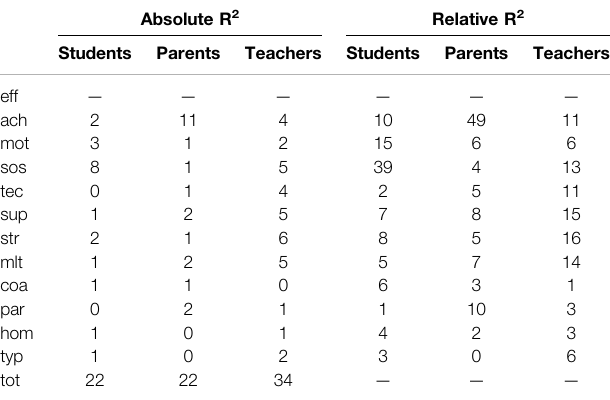
TABLE 9 | Relative weight analysis for student effort.